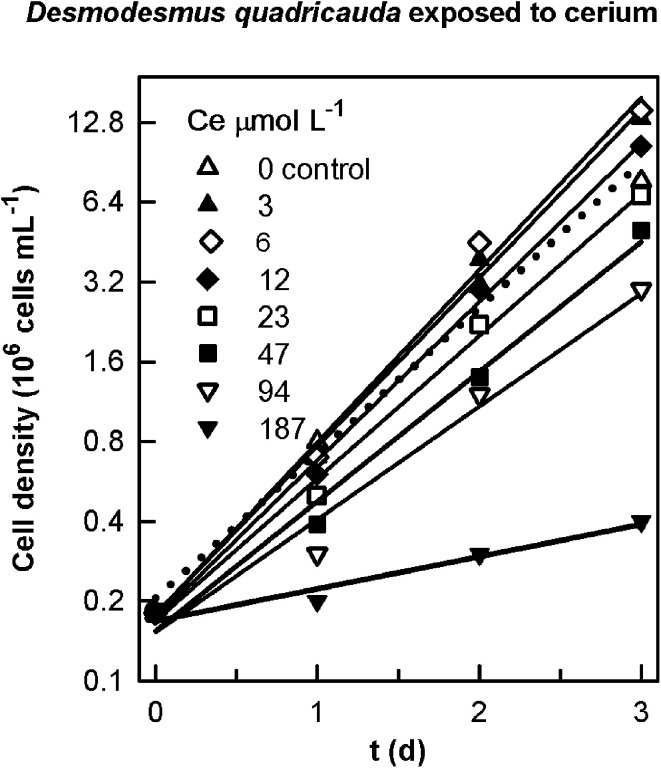
Changes in cell number in cultures of the alga Desmodesmus quadricauda grown in the presence of different concentration of cerium. The suspensions of cultures were grown in a 96-well microplate for 3 days.